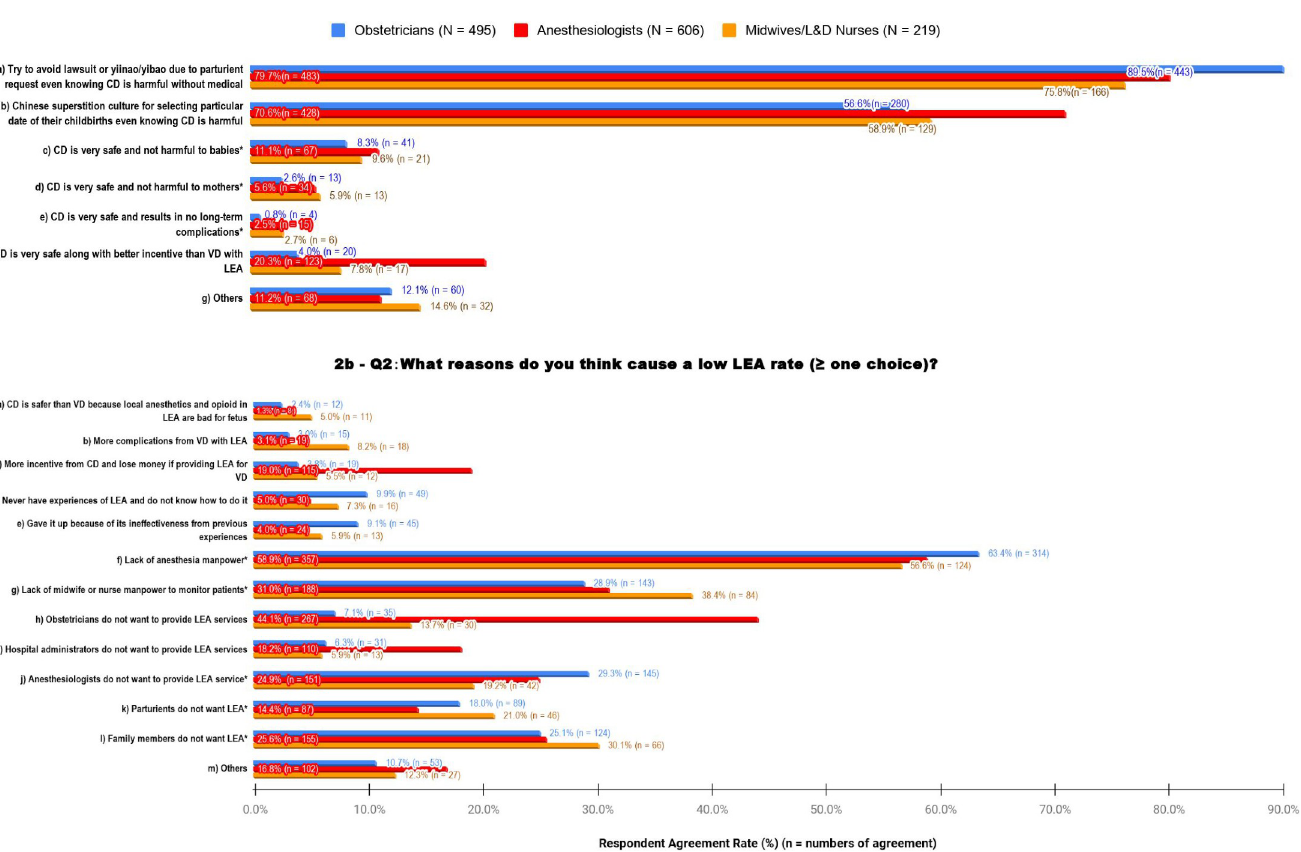
Fig 2. Reasons of high CD rate and low LEA use. a—Q1: What are your opinions on reasons for high CD rate? ( � one choice). b—Q2: What reasons do you think cause a low LEA rate? ( � one choice). Q1: question 1, Q2: question 2, CD: cesarean delivery, LEA: labor epidural analgesia, N: numbers of the individual study group, n: numbers of the respondents; � : no statistically significant difference at the level of p -value = 0.01.